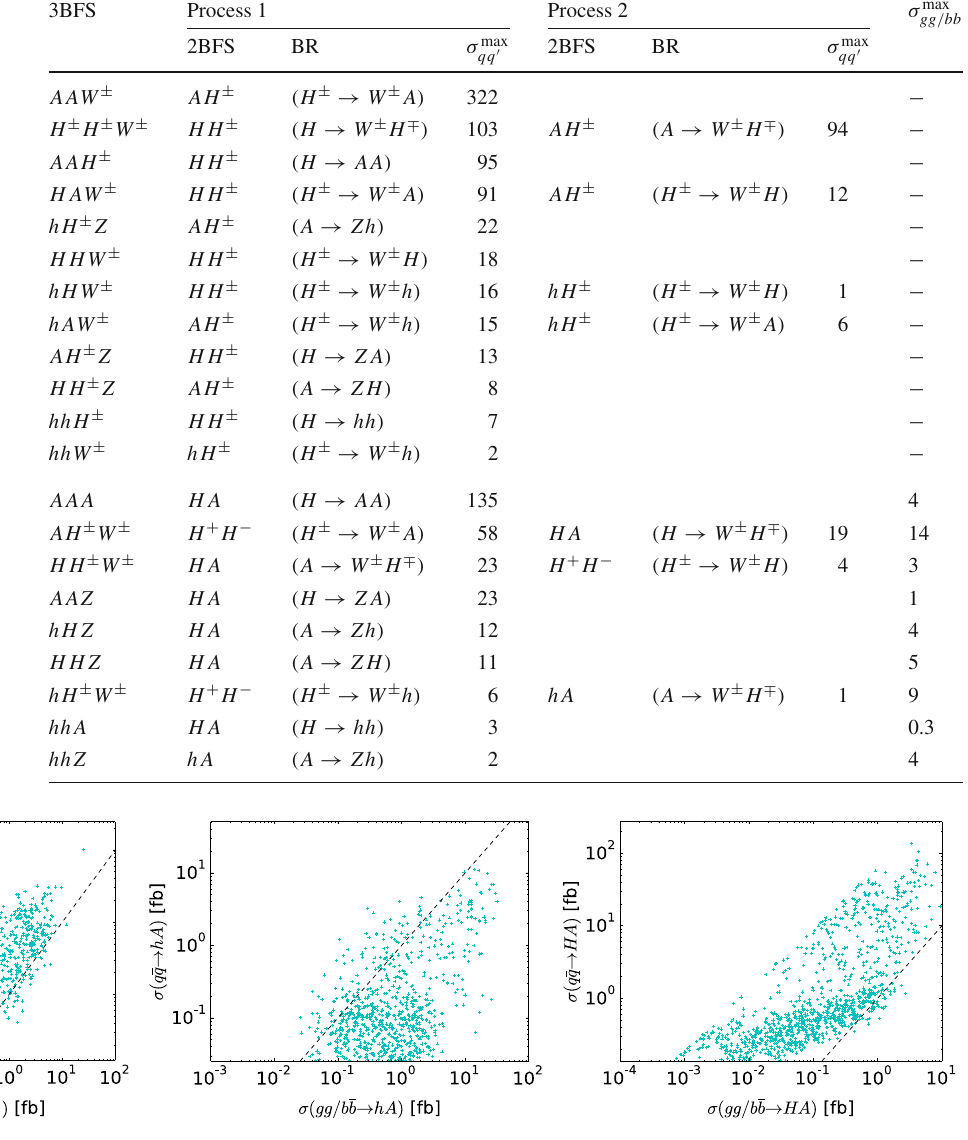
not kinematically available to any of our points. As with the charged 3BFSs, plots involving H ± → W ± A , H → AA , or H → AZ are sparsely populated, since these decays are only allowed for a small number of scanned